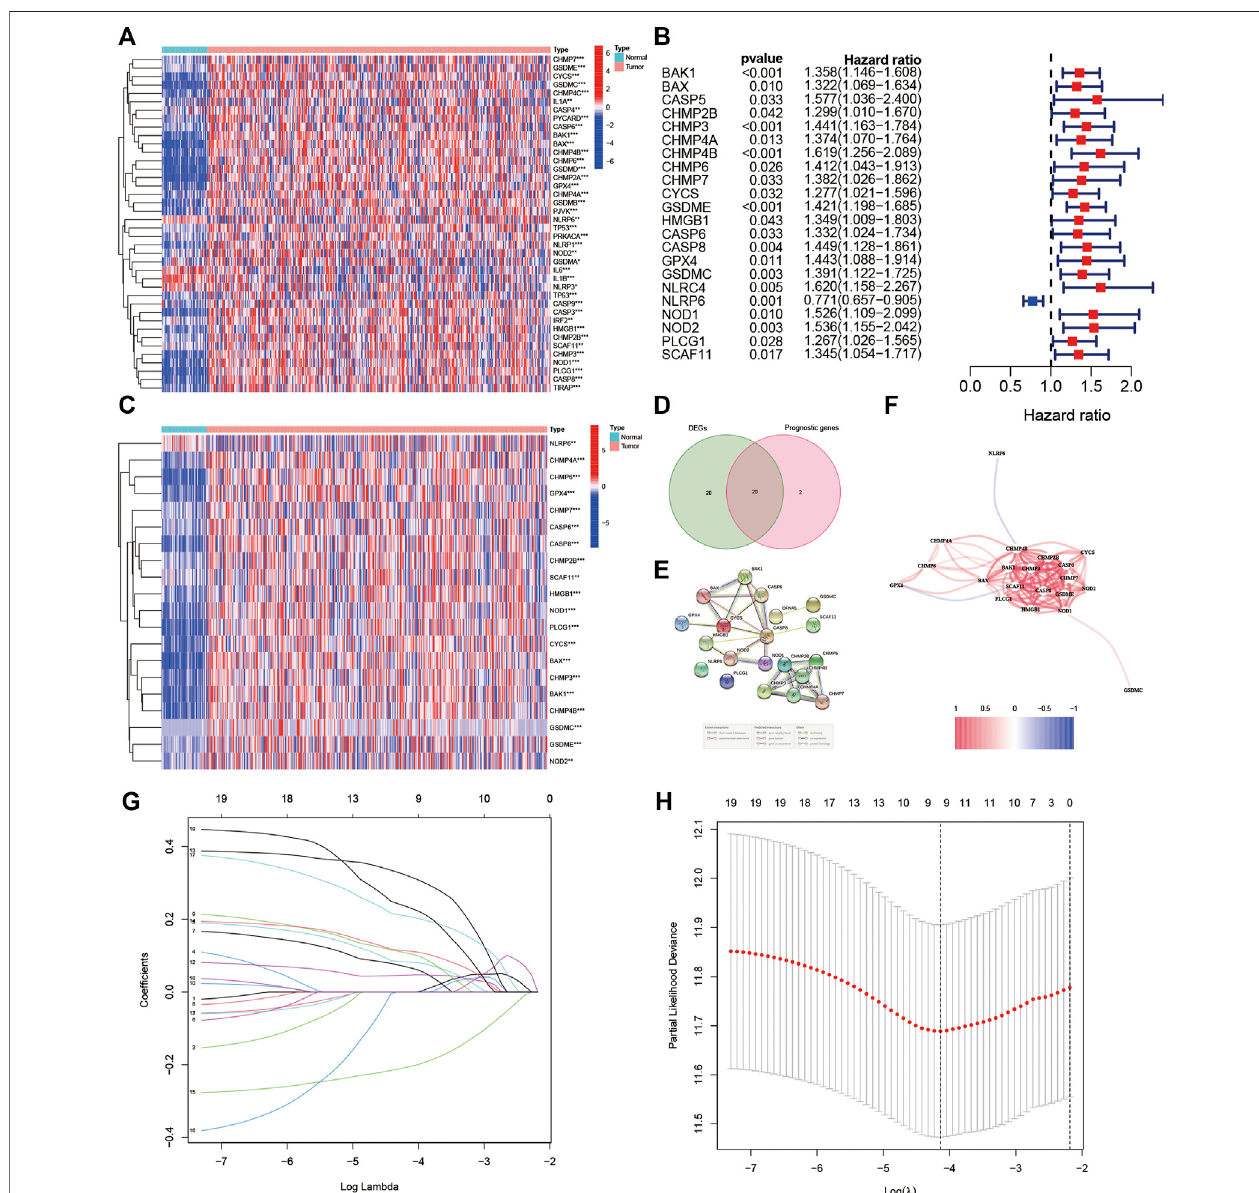
FIGURE 2 | Identi fi cation of the prognostic pyroptosis-related DEGs in the TGCA cohort. (A) Heatmap displaying the pyroptosis-related DEGs. (B) Forest plots displaying the outcomes of the univariate Cox regression analysis between the expression of pyroptosis-related DEGs and OS. (C) Heatmap showing the overlapping genes. (D) Venndiagramshowingtheoverlappinggenes. (E) Protein – proteininteractionnetwork. (F) Associationnetworkofgenes. (G) LASSOparameterpro fi lesofthe genes in the training cohort. (H) Parameter pro fi le plot with the log( λ ) sequence.